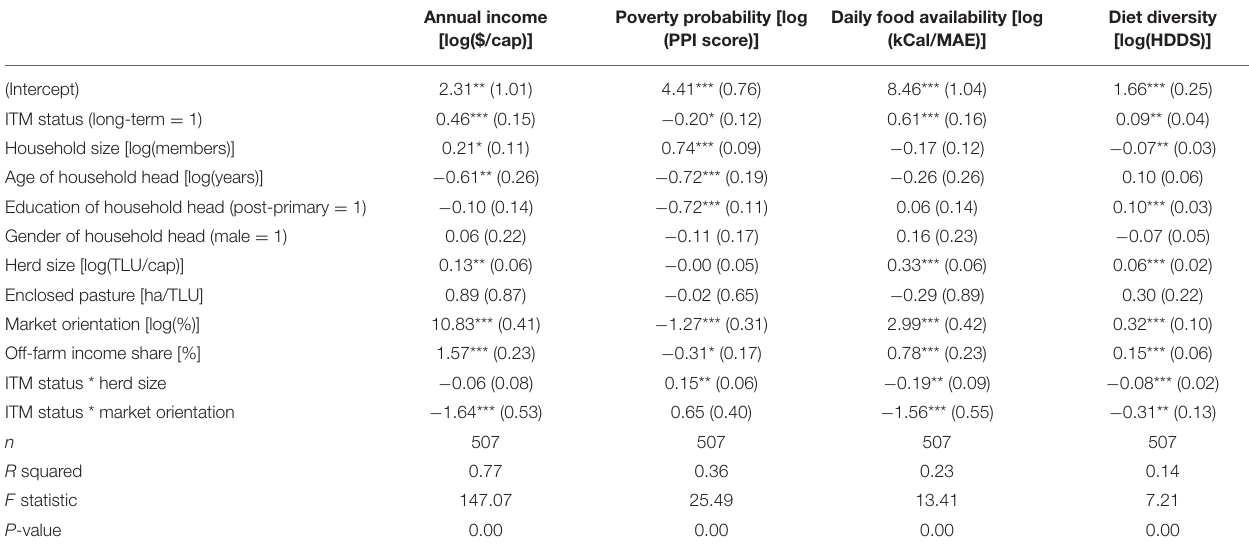
TABLE 7 | ITM vaccination and household livelihood indicators.